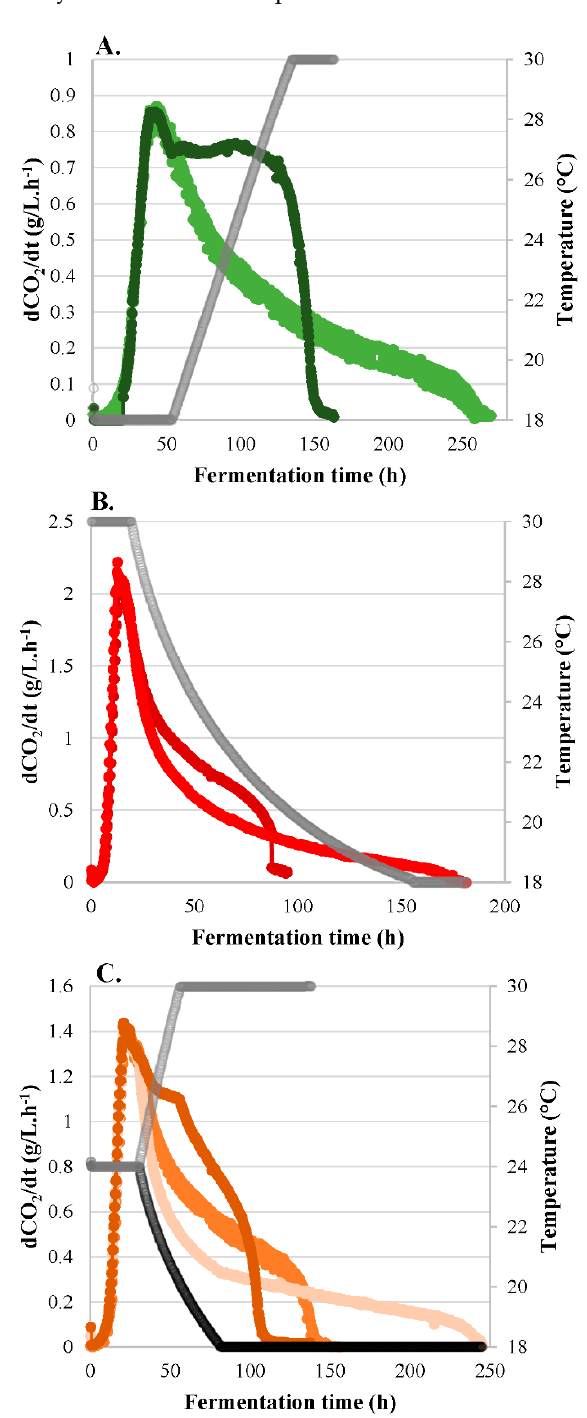
Figure 2. Fermentation kinetics analyzed at ( A ) 18 °C (light green) and 18-30 °C (dark green), ( B ) 30 °C (dark red) and 30-18 °C (light red) and ( C ) 24 °C (orange), 24-18 °C (light orange) and 24-30 °C (dark orange) with anisothermal temperature profiles (gray and black).